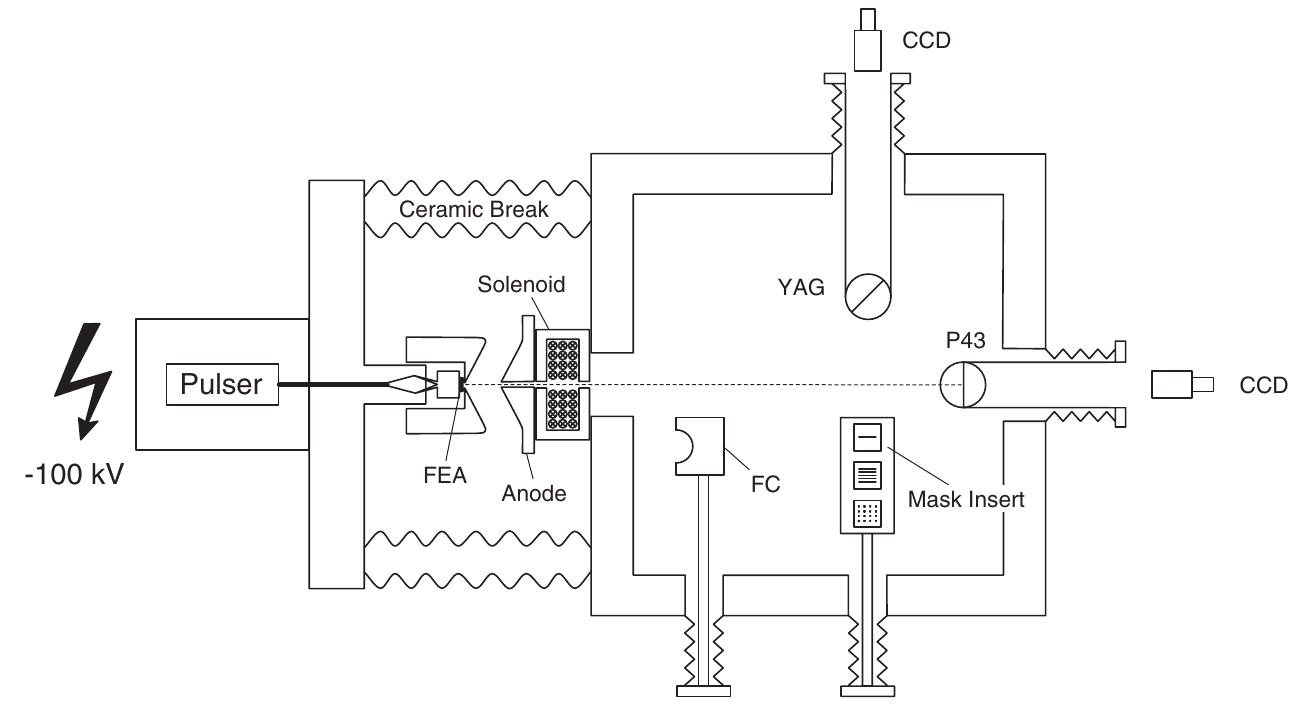
FIG. 1. Schematic overview of the 100 keV gun test stand (not to